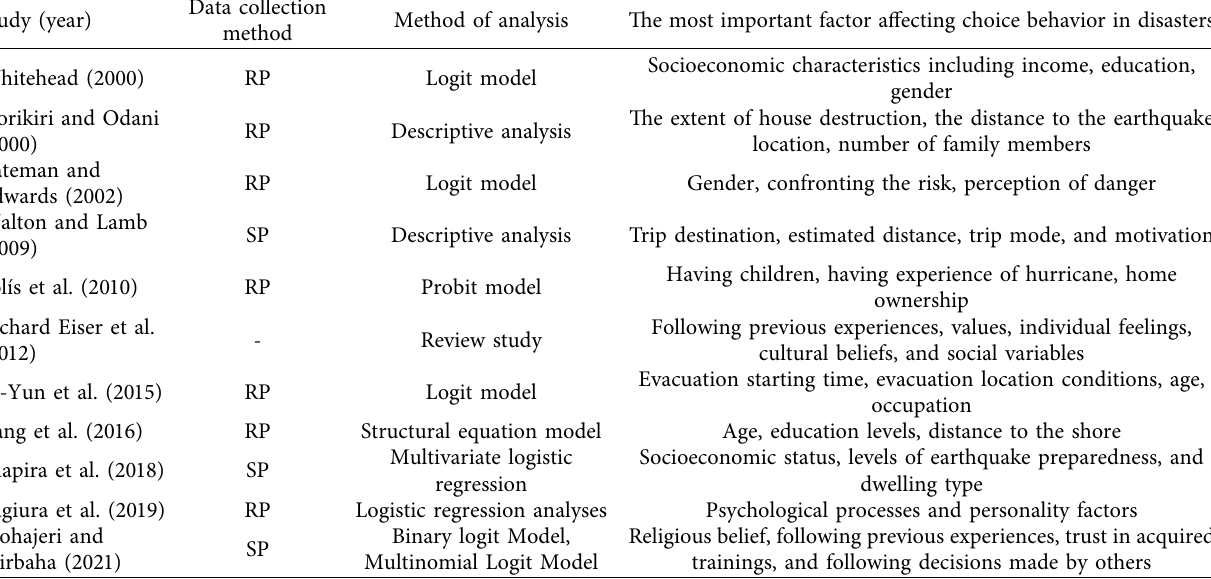
Table 1: Summary of selected literature on choice behavior in disasters.